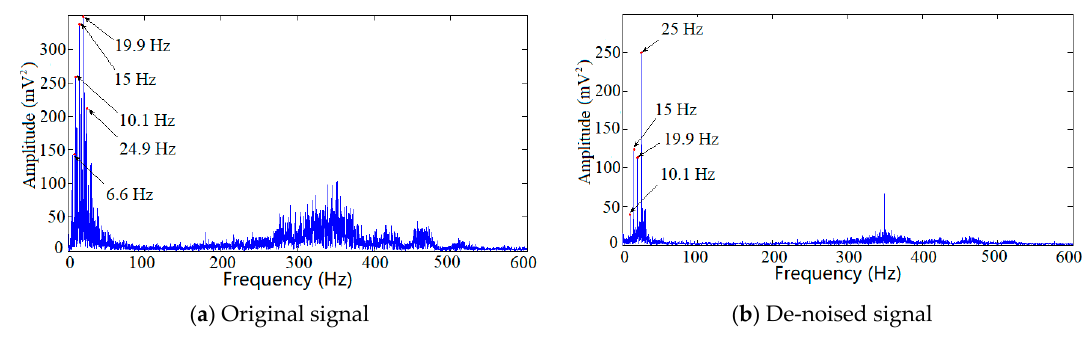
Figure 6. Spectra of measured vibration signal of Sensor 3.